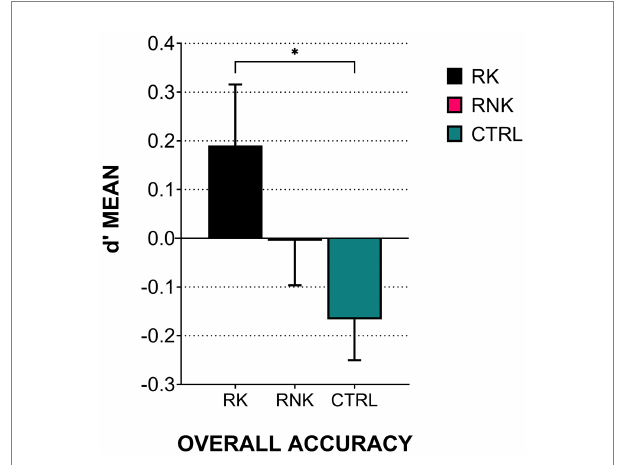
FIGURE 2 Overall accuracy (OA) among groups. The histograms indicate the average d’ scores, error bars indicate standard error. Asterisks indicate post hoc values of p < 0.05. RK, Rugby Kickers; RNK, Rugby Non-Kickers; and CTRL, control group.